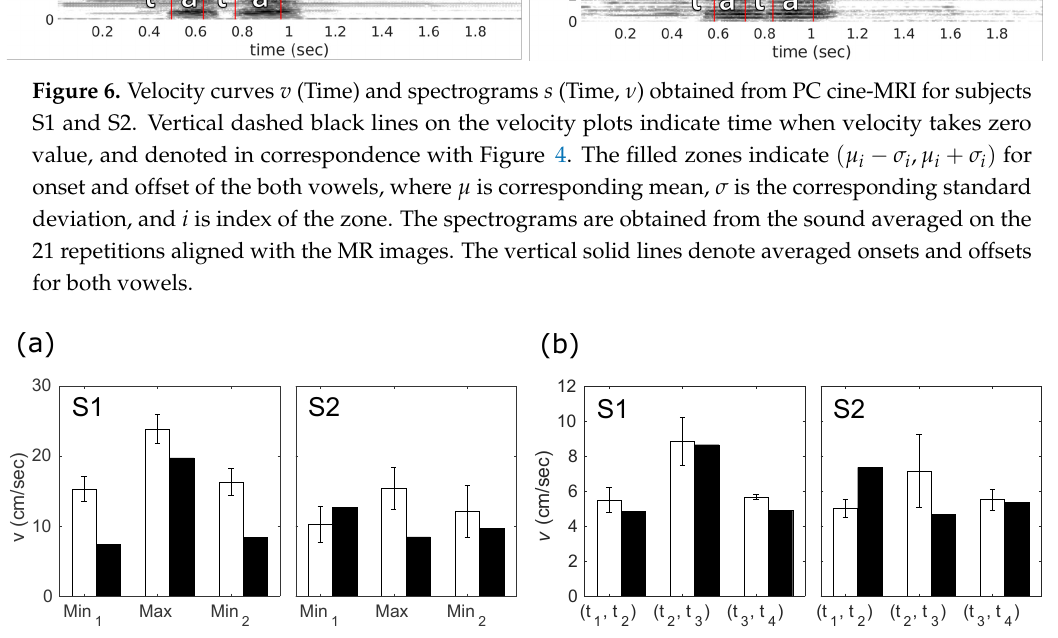
Figure 7. ( a ) peak velocity values evaluated with real-time MRI with manual labeling (white bars) and PC cine-MRI (black bars). Height of the bars represents mean absolute values of the first minimum, the maximum between two minima, and the second minimum. Error bars correspond to the standard deviation; ( b ) mean velocity values evaluated with real-time MRI with manual labeling (white bars) and PC cine-MRI (black bars). Height of the bars represents mean absolute values of the first opening having place within interval ( t 1 , t 2 ) , the closure between two openings (within ( t 2 , t 3 ) ), and the second closure (within ( t 3 , t 4 ) ). Error bars correspond to the standard deviation. Table 3. Mean (std. dev.) of time difference between feature points extracted from PC cine-MRI data ( t 1 − t 4 ) and from the corresponding sound ( q 1 − q 4 ). Time resolution of the MRI is 35.52 ms.